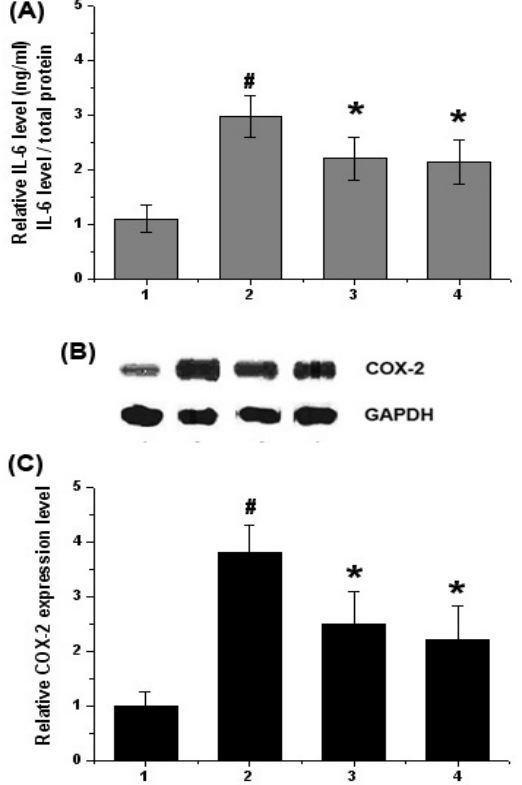
Figure 2. Effects of chrysophanol on the level of IL-6 and COX-2 in DSS-treated colon tissue. Experimental colitis in mice was induced by a 5% DSS dissolved in the drinking water for 7 days. Chrysophanol was administered at doses of 5 mg/kg once a day for 7 days prior to 5% DSS supplement. At the end of experiment, the colon tissues were cut out and homogenized. (A) The levels of IL-6 in the indicated groups were measured by ELISA; (B) The levels of COX-2 were evaluated by Western blot analysis; (C) The relative expression level of COX-2 was measured using an image analyzer.1) Control group; 2) DSS alone- treated group; 3) chrysophanol (5 mg/kg) + DSS treated group; 4) sulfasalazine (150 mg/kg) + DSS treated group. Values were represented in the mean ± S.E.M. (n = 5) of duplicate determinations from triplicate separate experiments ( # p < 0.05 vs. control, * p < 0.05 vs. DSS